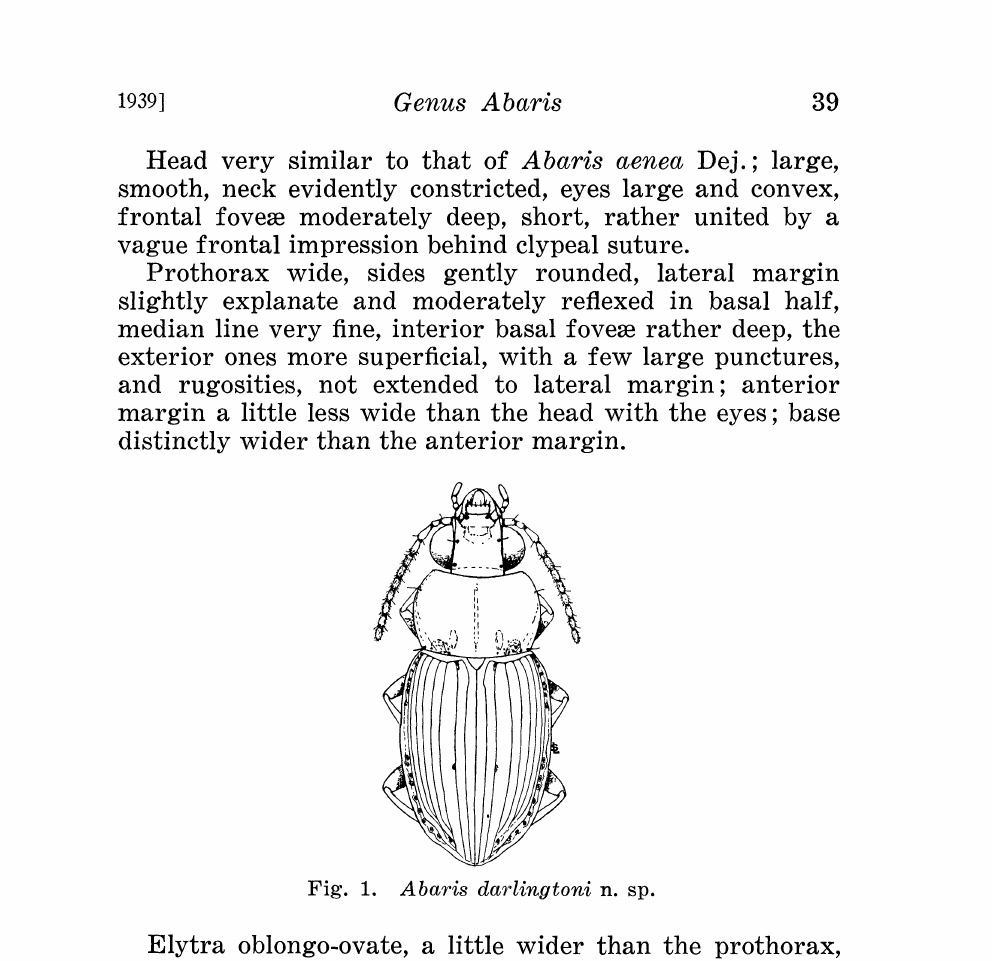
Fig. 1. A baris darligtoni n.